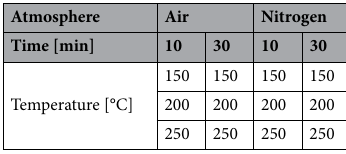
Table 1. Thermal treatment conditions.